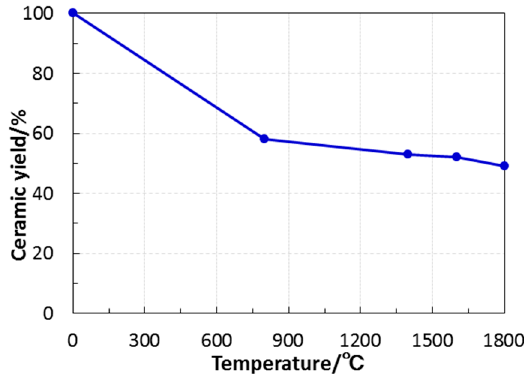
Figure 6. Weight change of EtOSZ during pyrolyisis up to 800 °C followed by heat treatment up to 1800 °C in N 2 .